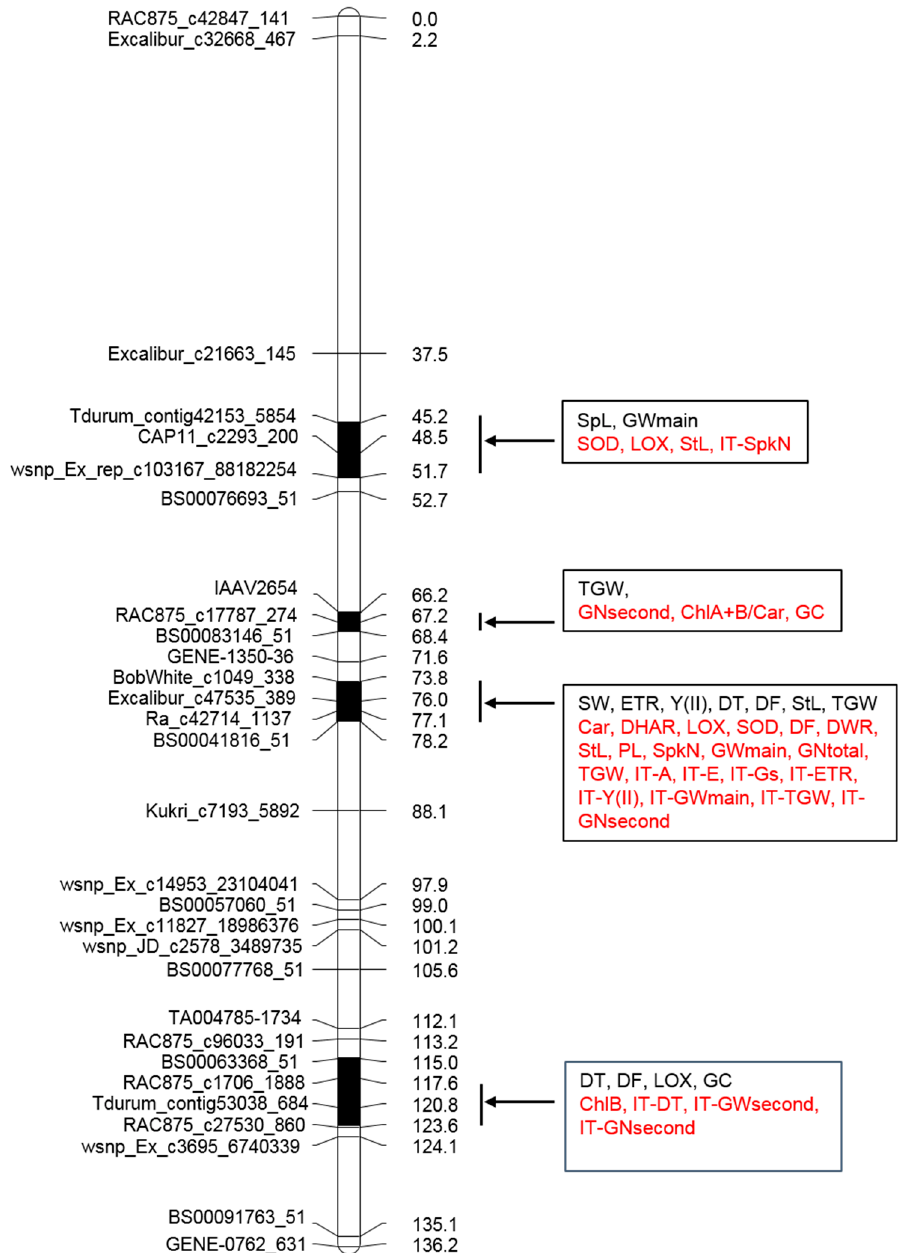
Figure 2. Genetic map of chromosome 2A showing QTL clusters for physiological and agronomical traits in SCRDH population S29 (YP 2A). Skeleton SNP markers are shown on the left, Kosambi distances (cM) are on the right side of the chromosome. The loci mapped under drought conditions are shown in red, under watering—in black.